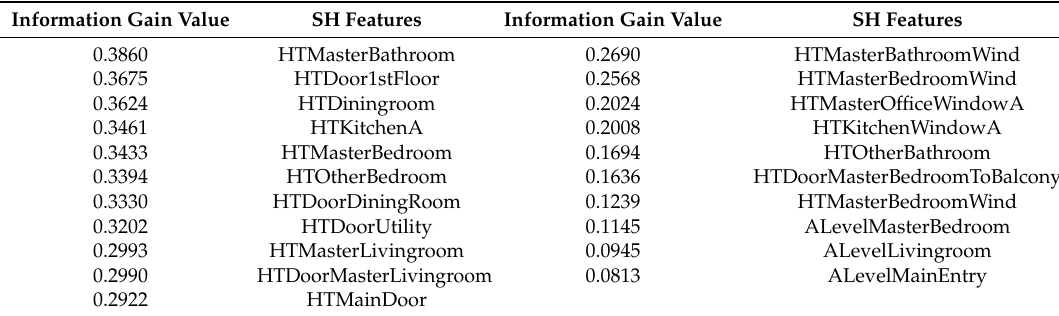
Table 14. InfoGain method predictions for outdoor PM 2.5 in IAQ 1 .